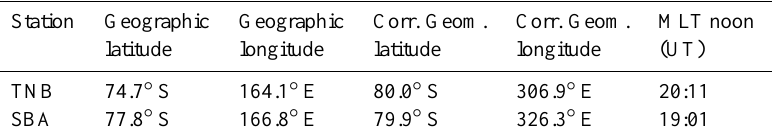
Table 1. Geographic coordinates, IGRF02 corrected geomagnetic coordinates and times in UT of the geomagnetic local noon for the two stations.